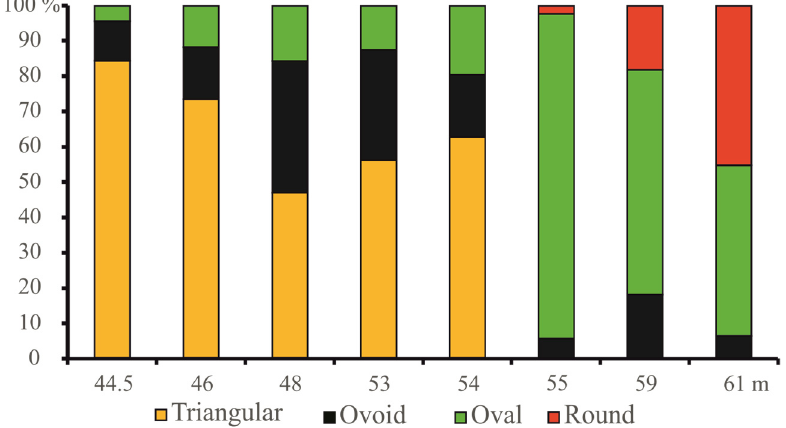
Figure 5. Percentage of different valves shapes of Alveolophora antiqua in core 517.